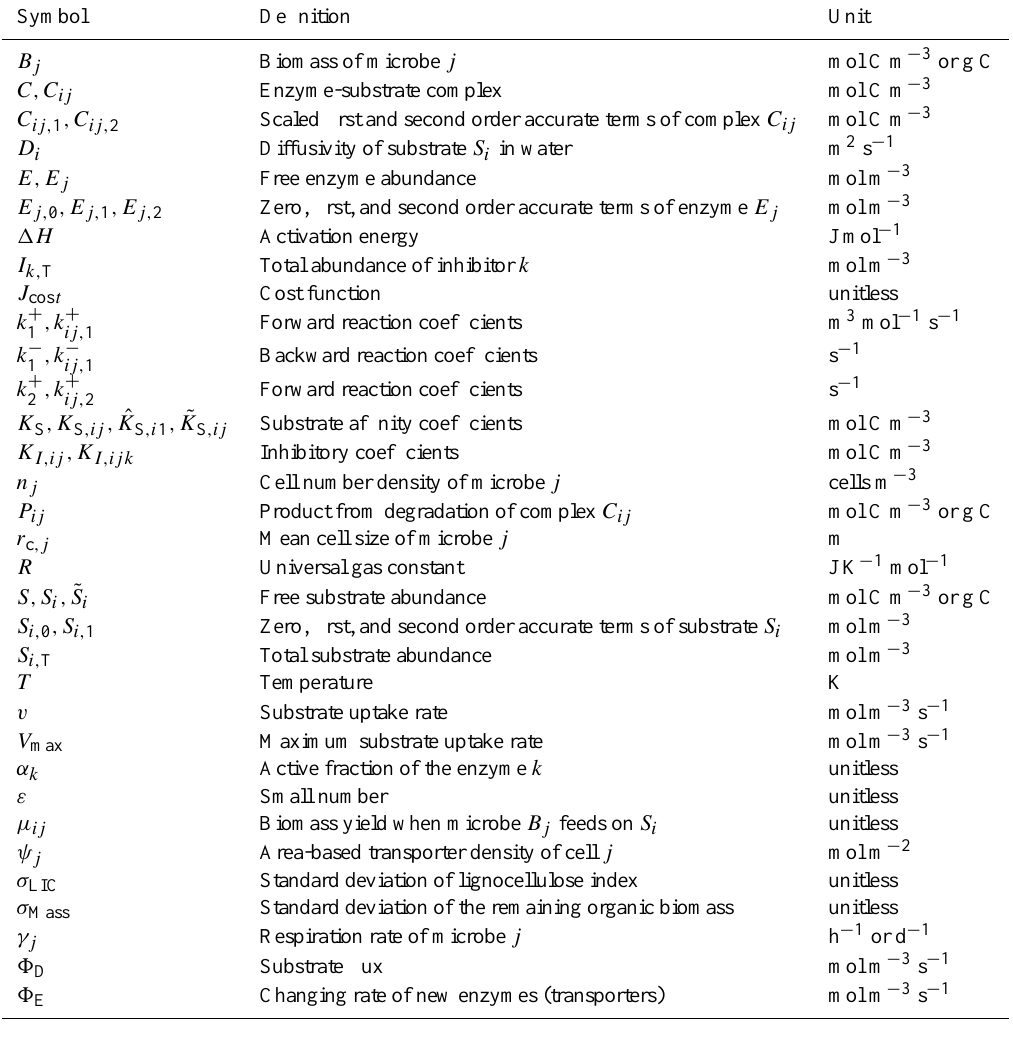
Table A1. Symbols used in paper, their definitions and corresponding units.